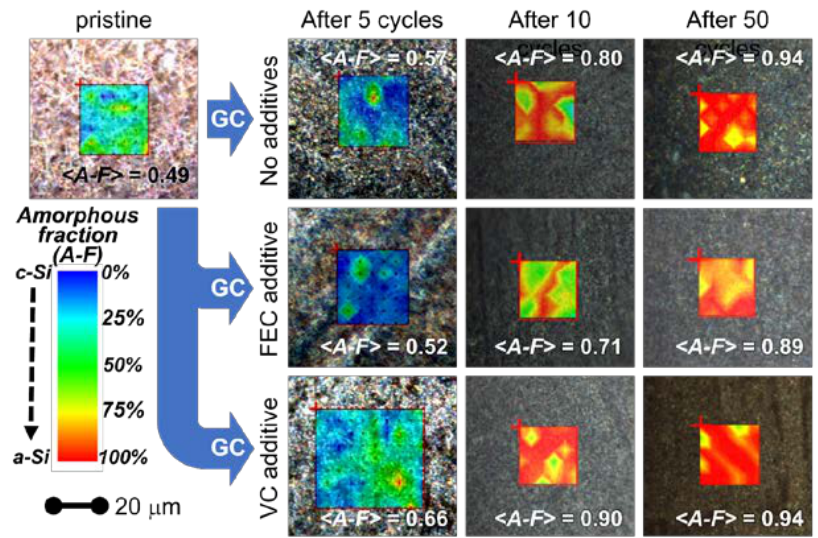
Figure 4. Superimposition of the white-light visible microscopy images and of the Raman maps obtained from amorphous fraction (color palette: blue-green-yellow-red passing from low to high amorphous-to-crystalline ratio). As explained in the text, the amorphous fraction was derived from the ratio between the areas of amorphous and crystalline silicon peaks. Results are reported for the pristine materials and for electrodes collected after cycling using different formulation of the electrolyte. The <A–F> values reported over the images are the estimated means of the amorphous fractions derived from all the measured spectra (see text for more details). GC stands for galvanostatic cycling.